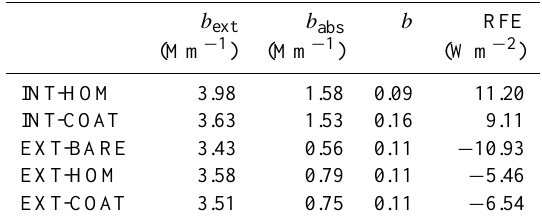
Table 1. Extinction ( b ext ) and absorption ( b abs ) coefficients and backscatter fraction ( b ) for the five mixing state representations. Ra- diative forcing efficiency (RFE) is calculated using Eq.